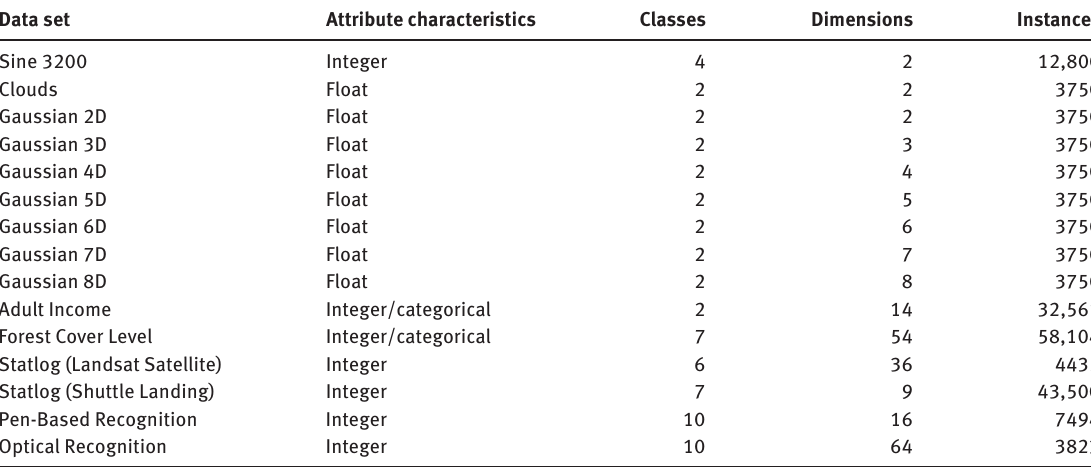
Table 1: Characteristics of All Data Sets. Data